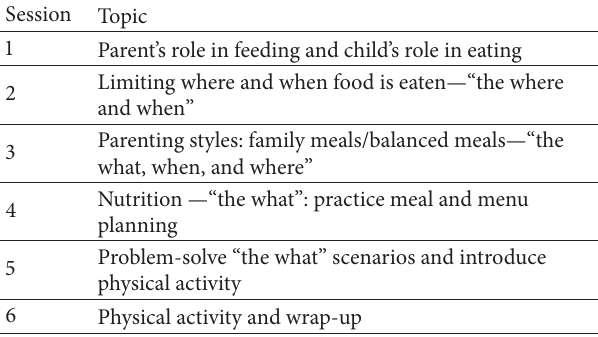
Table 2: Topics in the Feeding Dynamic Intervention (Study